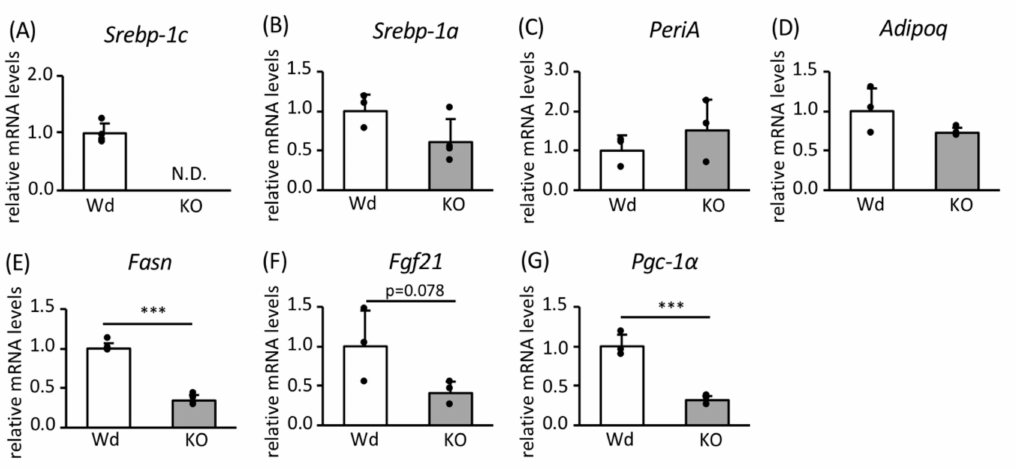
Figure 3. The e ff ects of SREBP-1c deficiency on the expression of adipocyte di ff erentiation markers and genes involved in FA biosynthesis and mitochondrial biogenesis in mature adipocytes. MEFs were obtained from four individual embryos of either Wd or Srebp-1c KO mice, di ff erentiated to mature adipocytes, and then RNA was extracted from each dish. The mRNA expression levels of Srebp-1c ( A ), Srebp-1a ( B ), PeriA ( C ), Adipoq ( D ), Fasn ( E ), Fgf21 ( F ), and Pgc-1a ( G ) were determined using RT-PCR and normalized to Rps18 expression ( n = 4). Values are means ± SDs. *** p < 0.001 vs. Wd, according to Student’s t